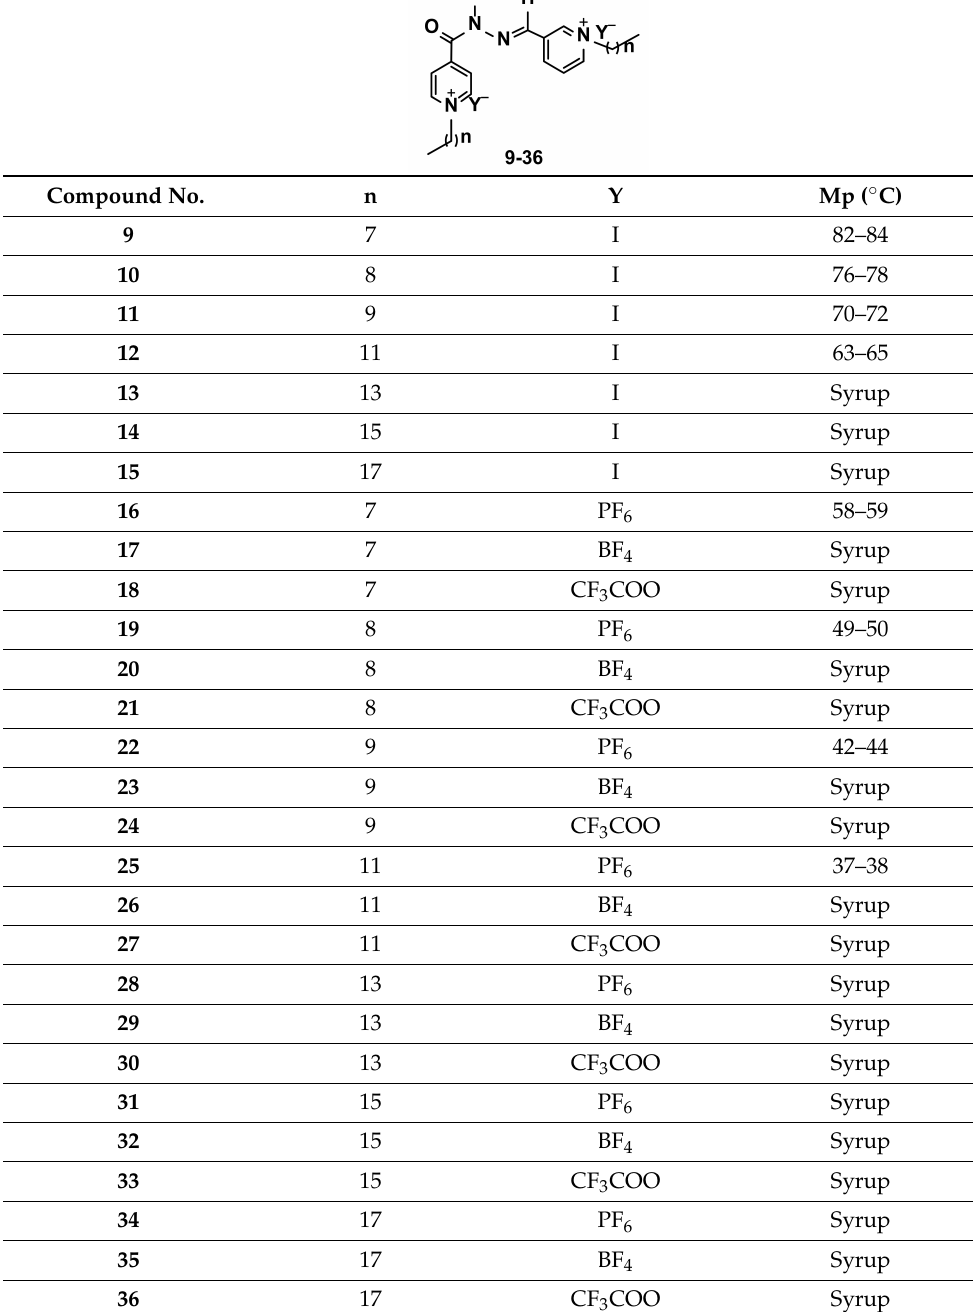
Table 1. List of the dicationic pyridinium lipophile-based ionic liquids incorporating hydrazone anion 9 – 36